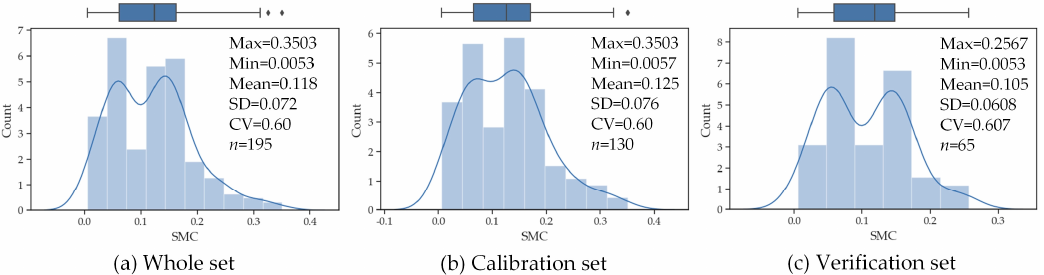
Figure 14. Box-plots, histograms, and descriptive statistics of SMC: ( a ) the whole set; ( b ) the calibration set; and ( c ) the verification dataset. Min: minimum, Max: maximum, SD: standard deviation, CV: coefficient of variation, n: the number of soil samples.